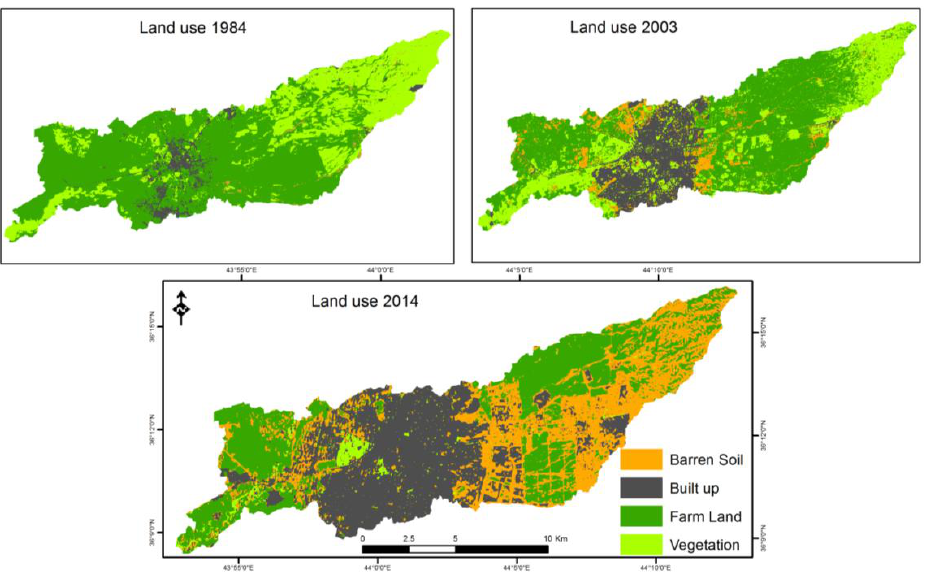
Figure 3. Land use change of the study area in 1984, 2003 and 2014.